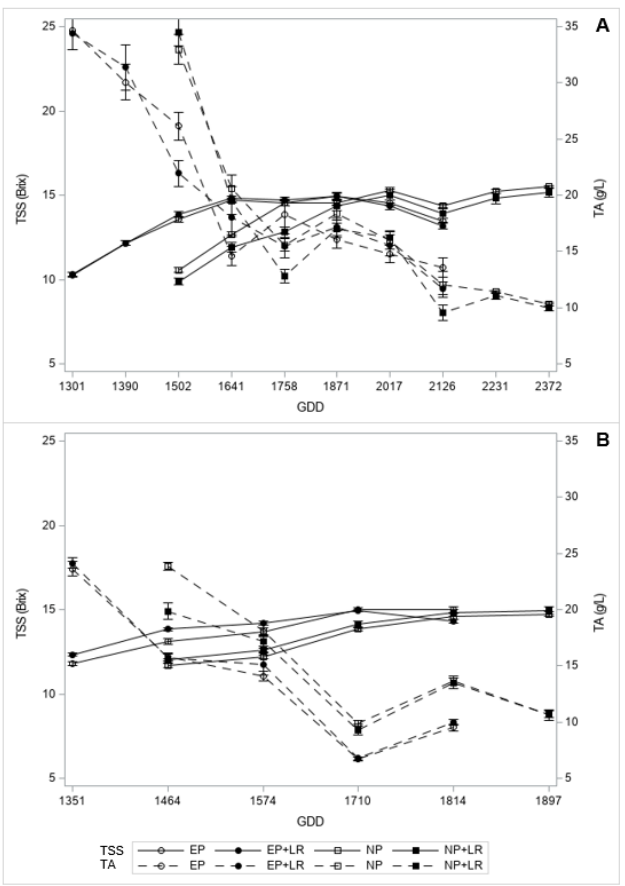
Figure 4. Weekly average ‘MidSouth’ total soluble solids (TSS) and titratable acidity (TA) for each treatment in Study 1 from veraison to harvest in 2020 ( A ) and 2021 ( B ) in McNeill, MS. EP, early pruning; EP + LR, early pruning + leaf removal; NP + LR, normal pruning + leaf removal; NP, normal pruning (control).